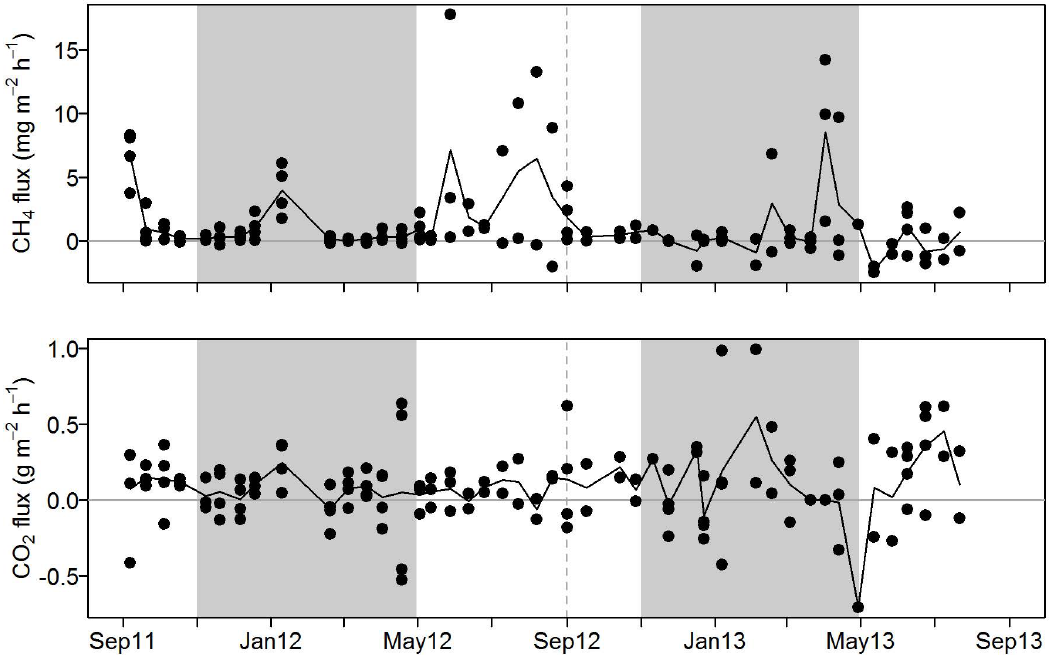
Figure 6. Methane fluxes (mg m -2 h -1 ) and carbon dioxide fluxes (g m -2 h -1 ) with the irrigation ditches. (Note the different mass units.) Individual flux values (solid circles) are shown together with the mean of each measurement day (black line). The main growing seasons (May to October) are indicated by a grey